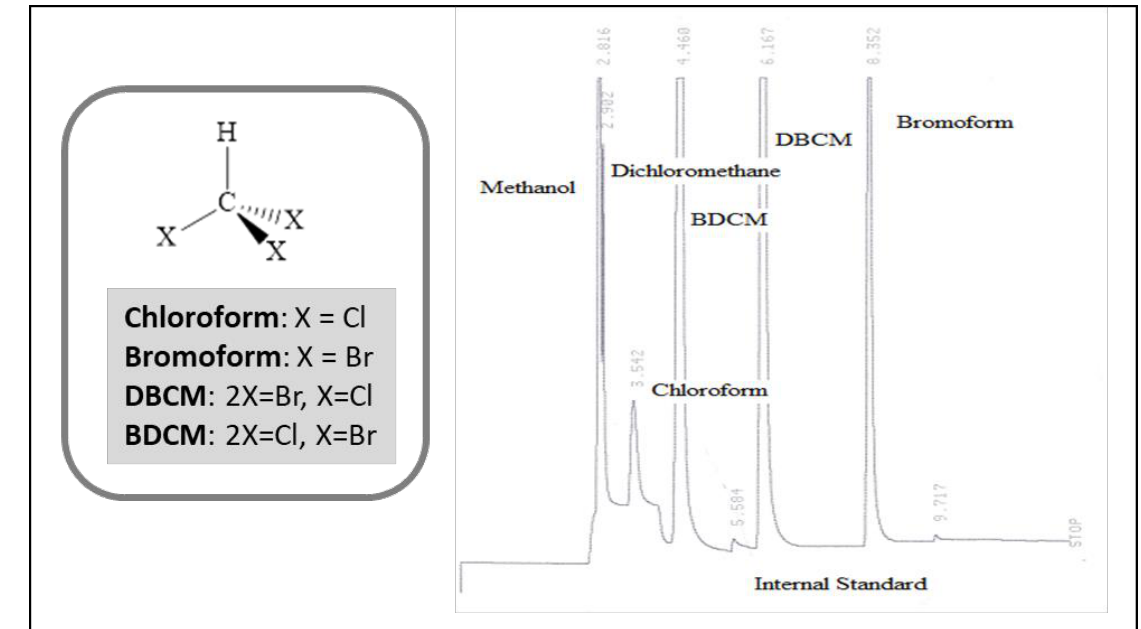
Figure 1. A typical chromatographic profile of component THMs (10 ppm) obtained using the DAI method. The inset (left hand side) shows the molecular structure of the various THMs investigated herein. Table 1. International Agency for Research on Cancer (IARC) classification and United States